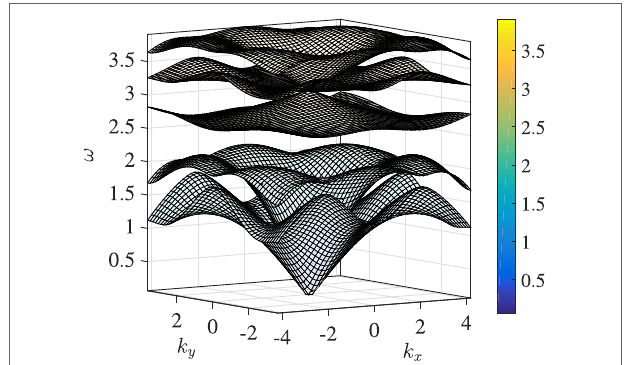
FIGURE 2 | The Bloch-Floquet dispersion surfaces for a triangular lattice with resonators whose lattice parameters are listed in set 1 of Table 1 . The color scale represents Bloch-Floquet frequencies ω .